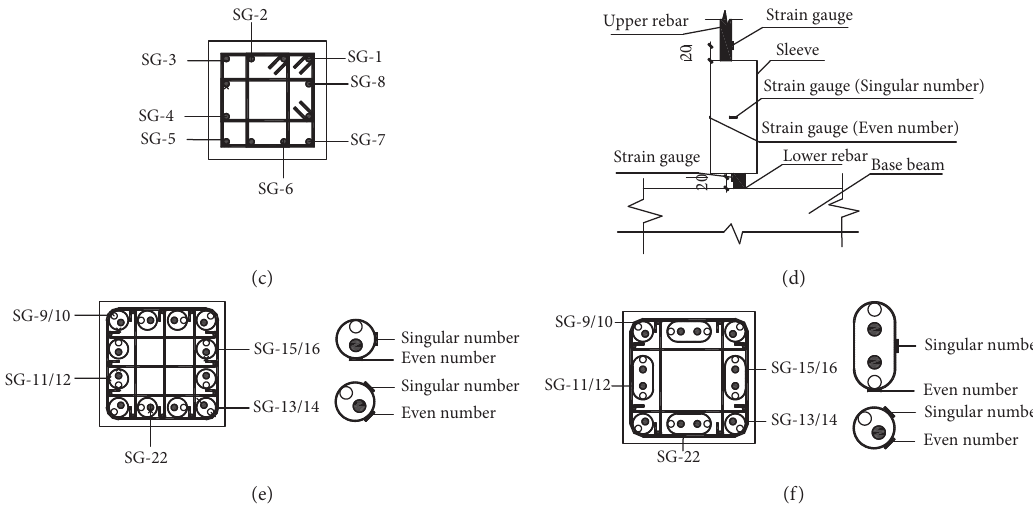
Figure 7: Arrangement of strain gauge for YZ1 and YZ2. (a) On rebars of YZ1, 20mm above the base beam. (b) On rebars of YZ2, 20mm. (c) On rebars of YZ1 and YZ2, 20mm above the top end of sleeve above the base beam. (d) Sleeve strain gauges. (e) On sleeves of YZ1, at the mid-height of sleeves. (f) On sleeves of YZ2, at the mid-height of sleeves.